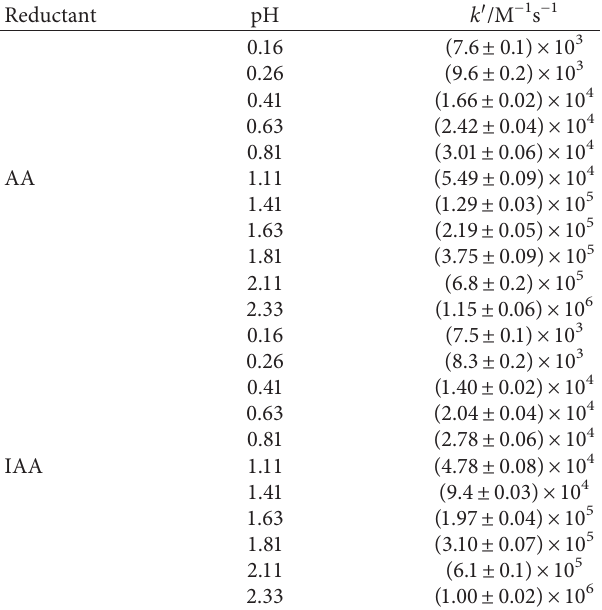
Table 1: Observed second-order rate constants for the reduction of [IrCl 6 ] 2– by AA and IAA at 25.0 ° C and 1.0M ionic strength. Reductant